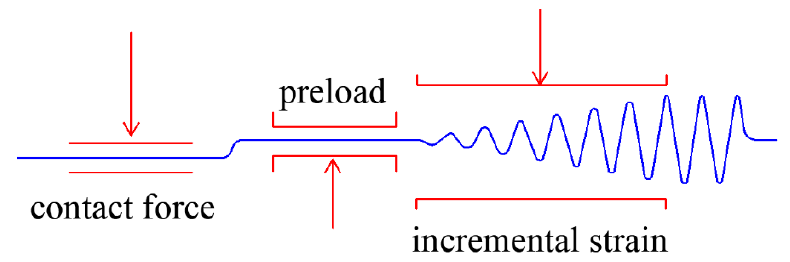
Figure 3. DMA strain scanning force loading process.